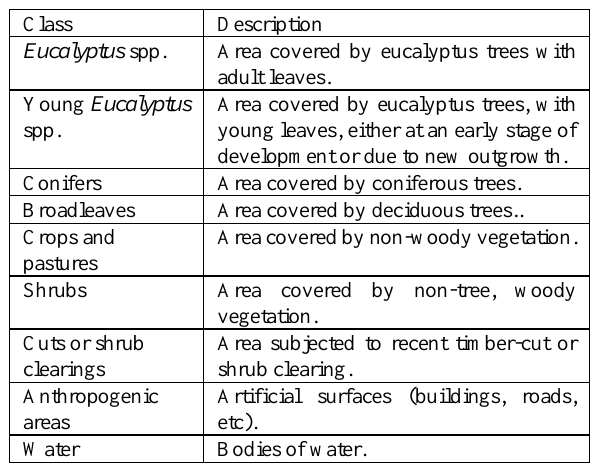
Table 2. Target classes used in the general